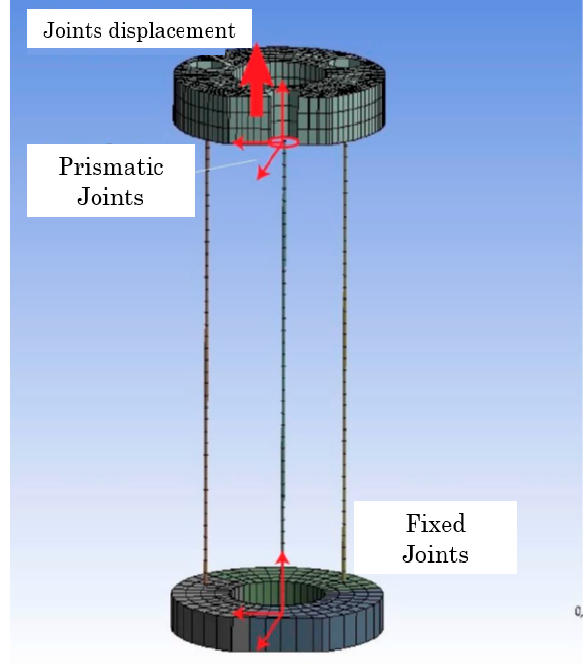
Figure 16. Articulations and displacements of the threads. Source: authors. Table 1. Displacement of the threads. Configuration A. Source: